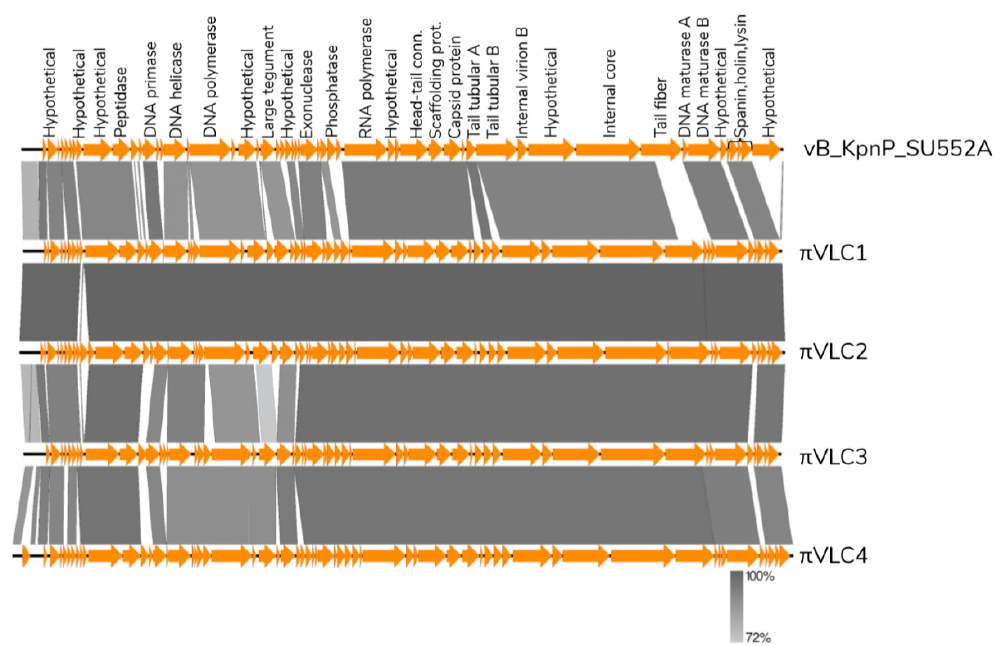
Figure 6. Genome comparison of Klebsiella phages π VLC1-4 and the previously characterized Klebsiella phage vB_KpnP_SU552A (closest genome by ANI values) with EasyFig [11]. The arrows indicate the product encoded in each CDS, omitting small CDS to facilitate visualization.